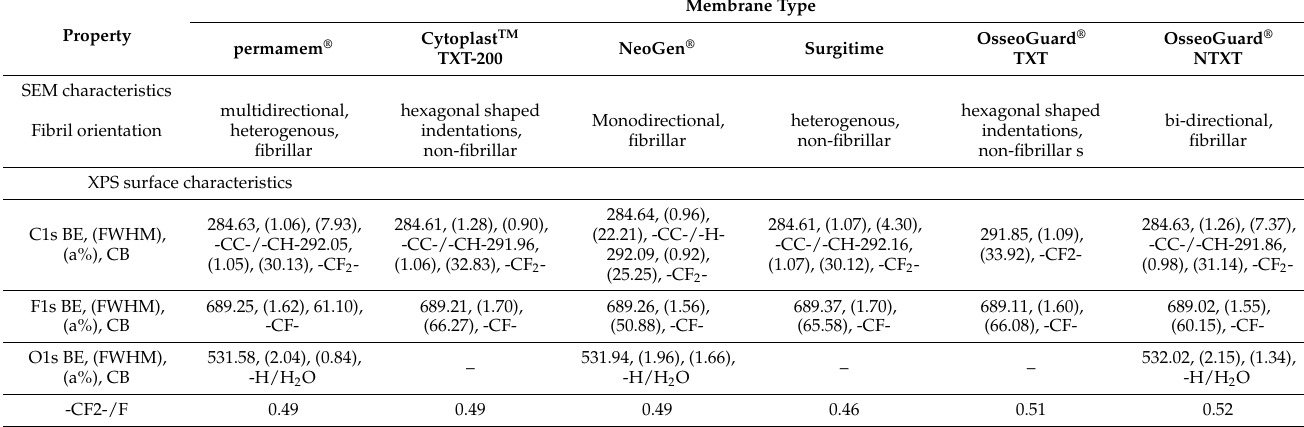
Table 2. Surface characteristics of membranes compared in this study.